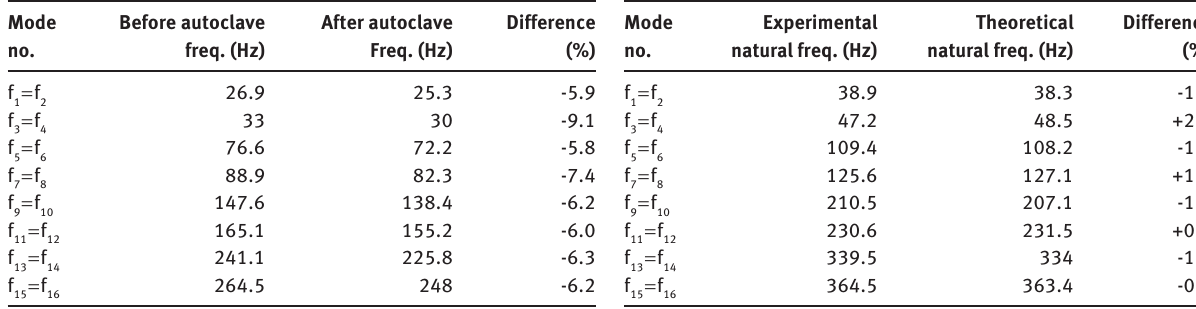
Table 13: Comparison between natural frequencies of truncated cone # 2 (experiment and theory after autoclave treatment).